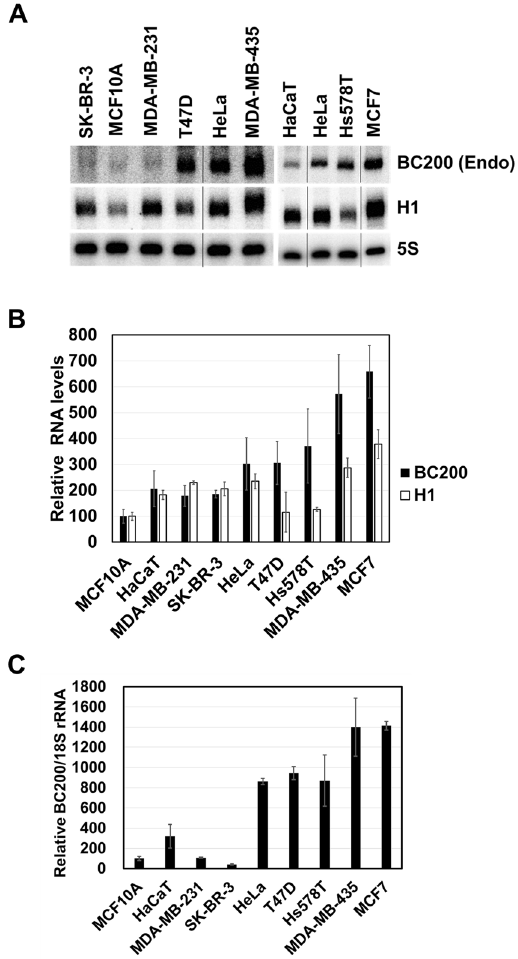
Figure 5. Variations of BC200 RNA levels in cancer cells. Total cellular RNA was purified from cervical HeLa cells, breast cancer cell lines (MCF7, SK-BR-3, MDA-MB-231, MDA-MB-435, Hs578T, and T47D), the normal breast cell line, MCF10A, and the normal keratinocyte cell line, HaCaT. ( A ) The endogenous expression levels of BC200 RNA and H1 RNA were assessed by Northern blotting. The spliced images from the same Northern membranes were shown with the insertion of dividing lines between spliced lanes. ( B ) The Northern results were normalized with respect to the expression of the 5S rRNA. ( C ) Quantitative analysis of BC200 RNA abundance. Total cellular RNAs were subjected to qRT-PCR using 18S rRNA as a control RNA. BC200 (Endo), endogenous BC200